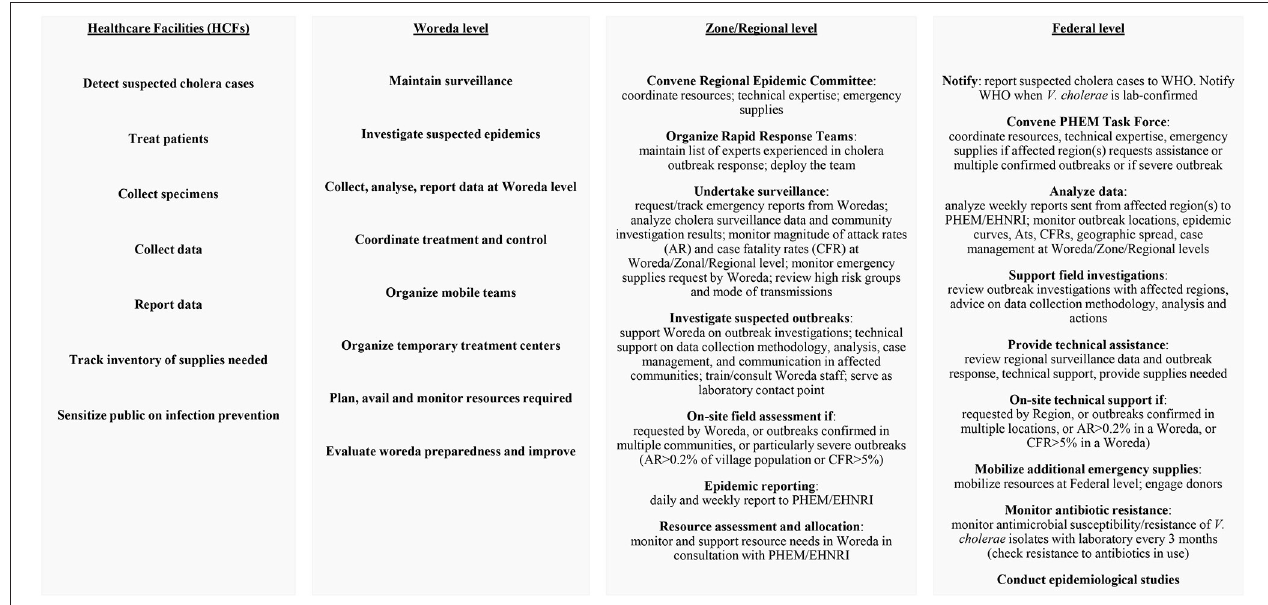
FIGURE 1 | Responsibilities in cholera detection and outbreak control.